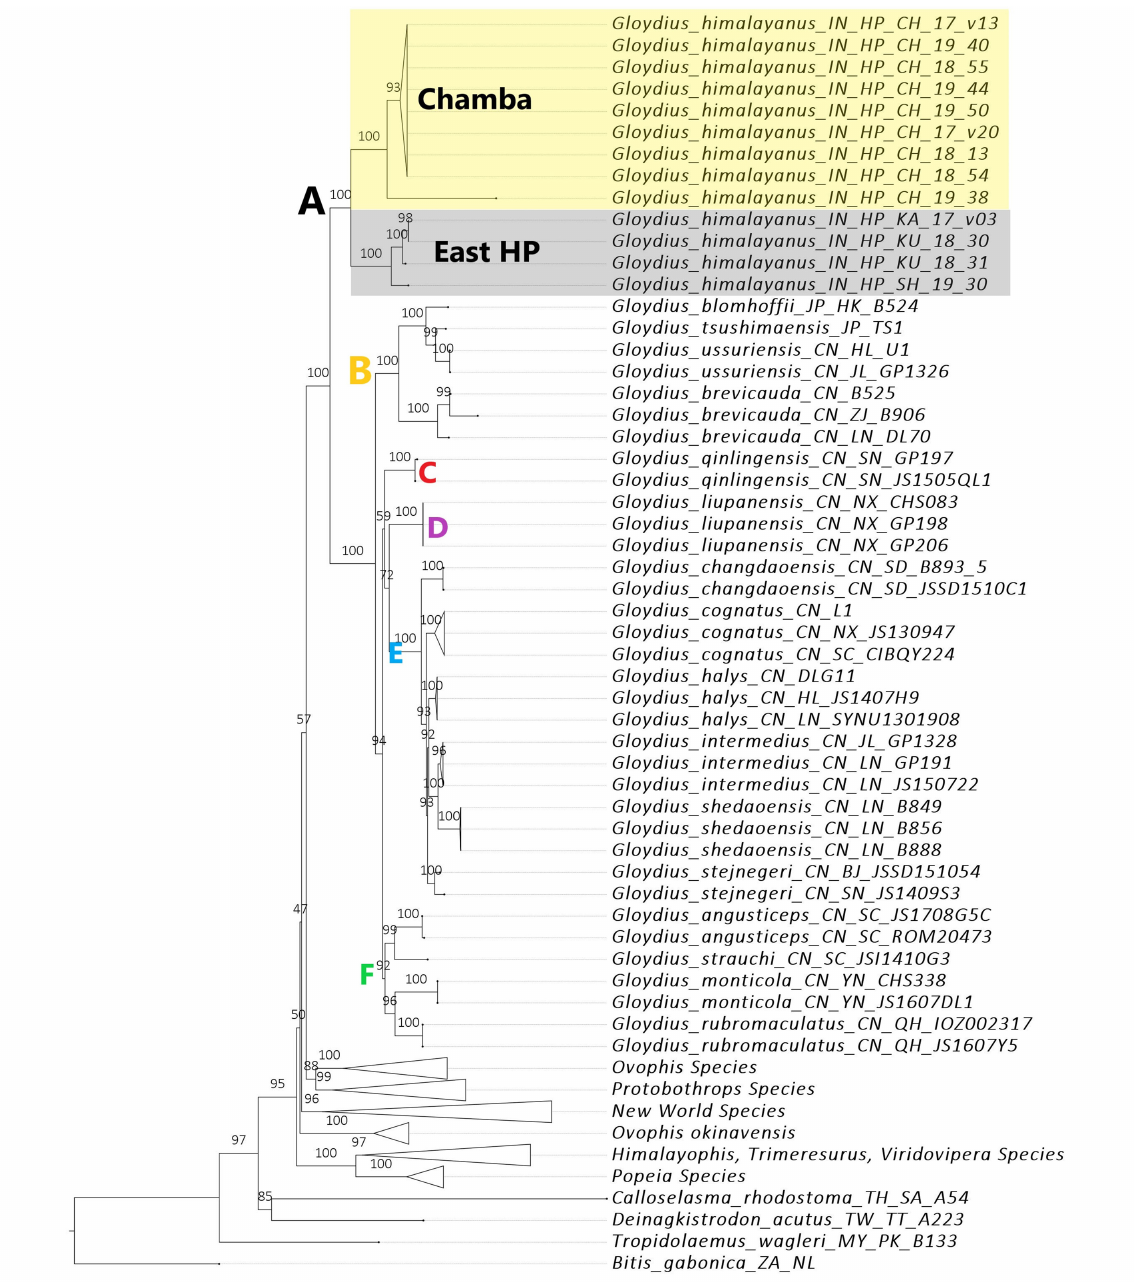
Fig. 2. Maximum-likelihood tree: branch labels indicate the ultrafast bootstrap support (%). In this and subsequent figures, each clade is labelled and designated in a particular colour. These clades correspond to: A . Gloydius himalayanus (Günther, 1864) (black). B . G . blomhoffii (H. Boie, 1826), G. brevicauda (H. Boie, 1826), G. ussuriensis (Emelianov, 1929) (yellow). C . G . qinlingensis Song & Chen, 1985 (red). D . G . liupanensis Liu, Song & Luo, 1989 (purple). E . G . halys (Pallas, 1776), G. intermedius (Strauch, 1868), G. changdaoensis Li, 1999, G. cognatus (Gloyd, 1977), G. stejnegeri (Rendahl, 1933), G. shedaoensis (Zhao, 1979) (blue). F . G. angusticeps Shi, Yang, Huang, Orlov & Li, 2018, G. strauchi (Bedriaga, 1912), G. monticola (F. Werner, 1922), G. rubromaculatus Shi, Wang, Chen, Fang, Ding, Huang, Hou, Liu & Li, 2017